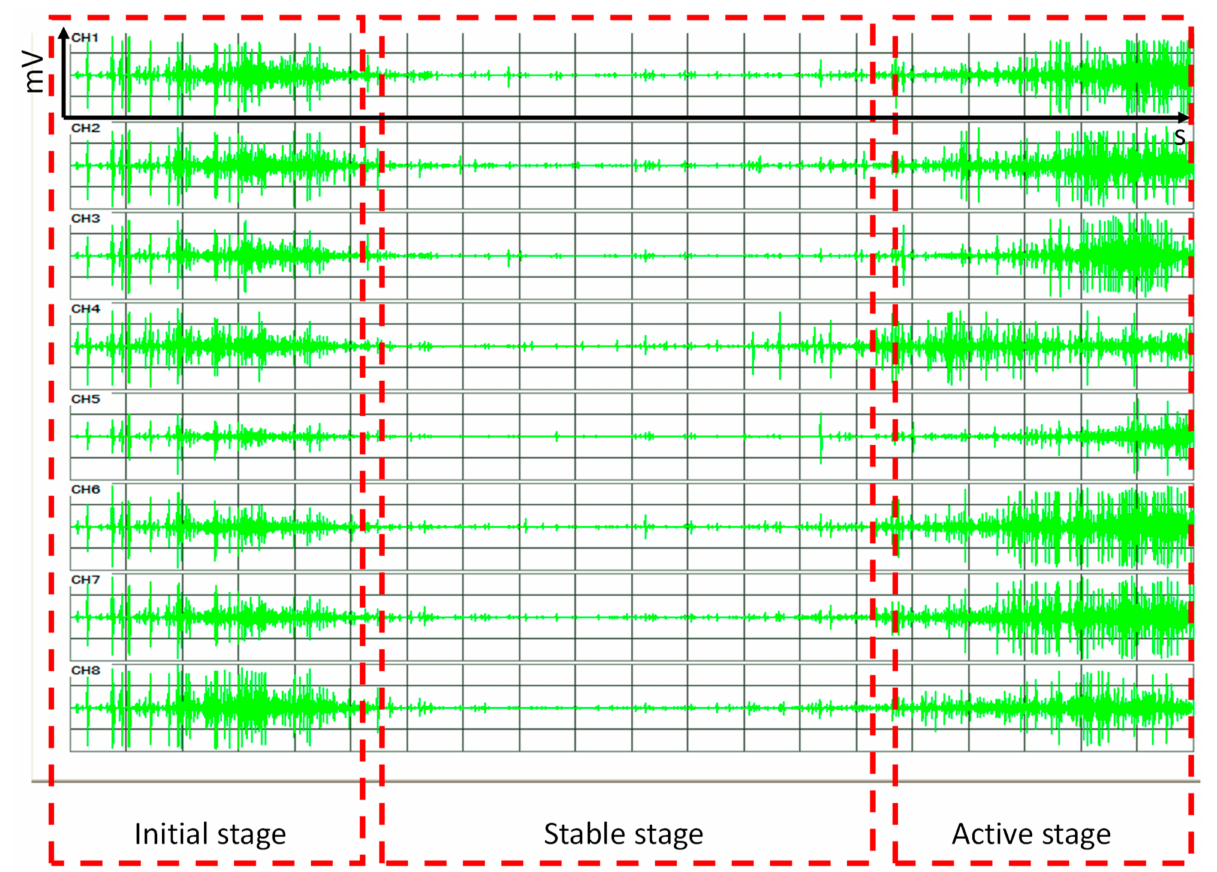
Figure 5. Acoustic emission waveforms of 8 channels during the whole loading